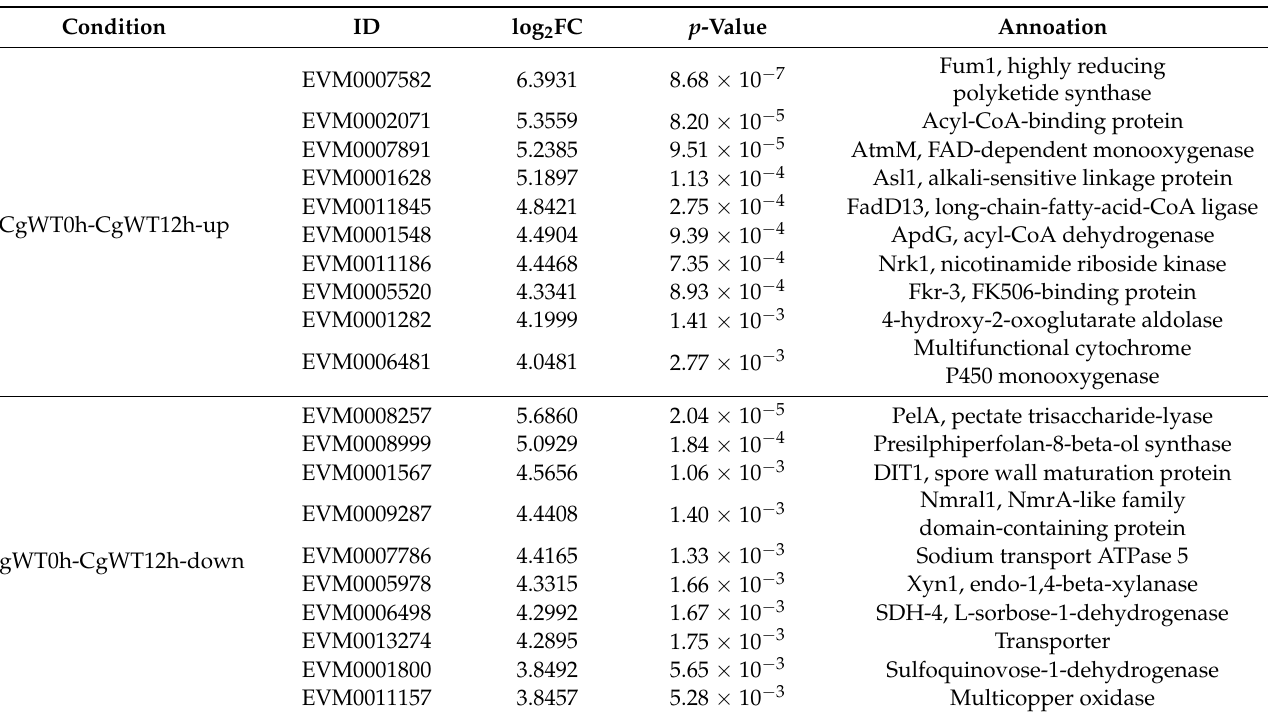
Figure 4. Number of DEGs in the CgWT12h sample. Red and green indicate upregulated and downregulated expression, respectively. Table 2. Upregulated and downregulated C. gloeosporioides genes between the conidia and mature appressorium.